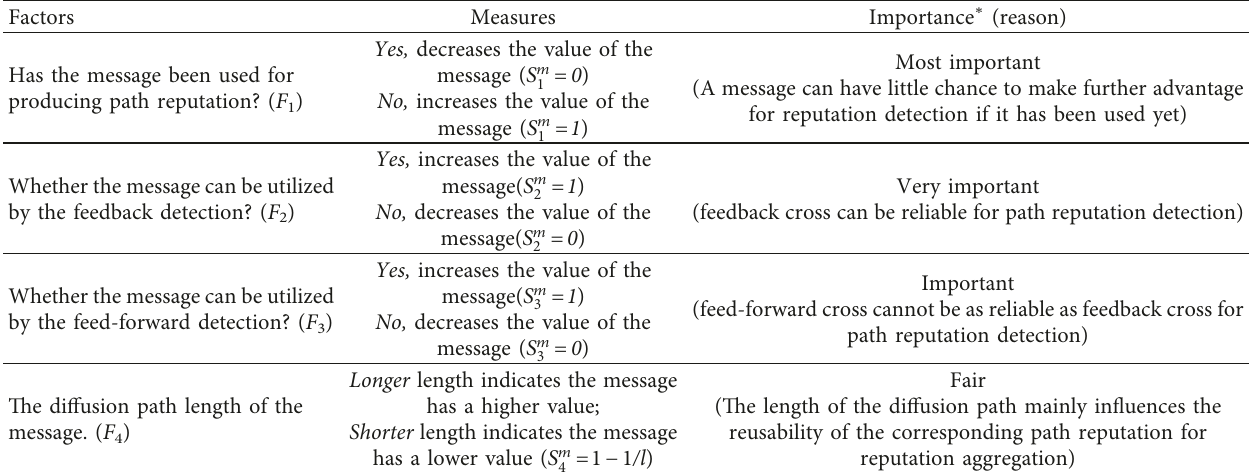
Table 2: Factors for evaluating the detection value of a